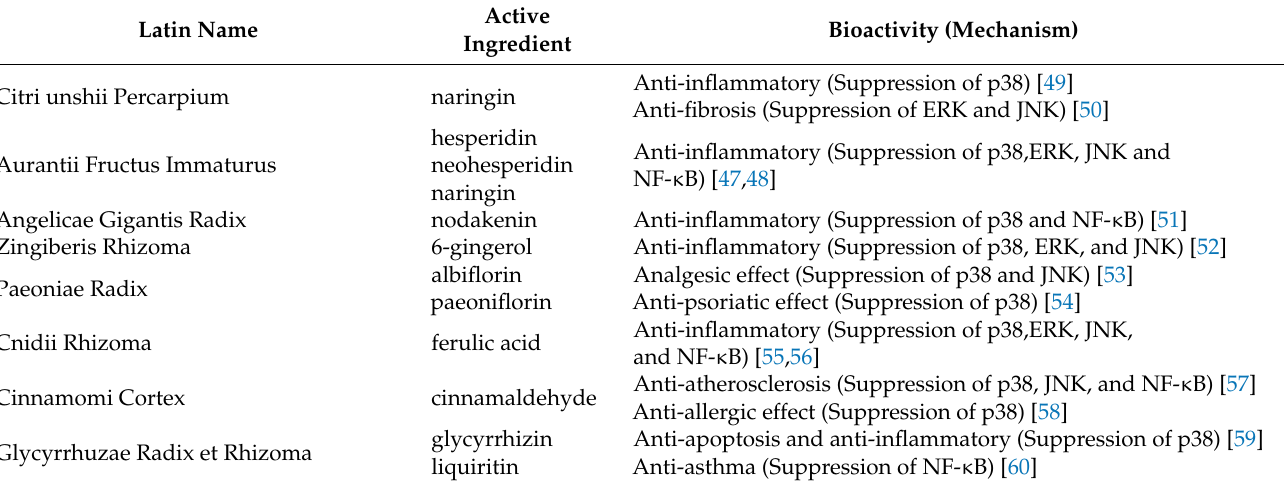
Table 1. Bioactive ingredient of OJS